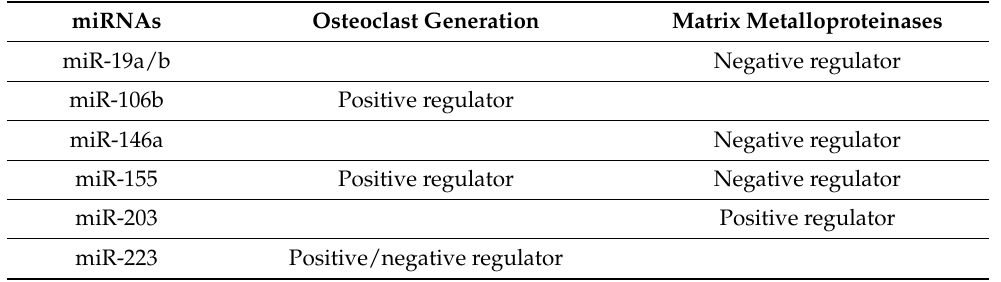
Table 7. Role of microRNAs (miRNAs) in bone destruction in rheumatoid arthritis (RA) [8,87]. miRNAs Osteoclast